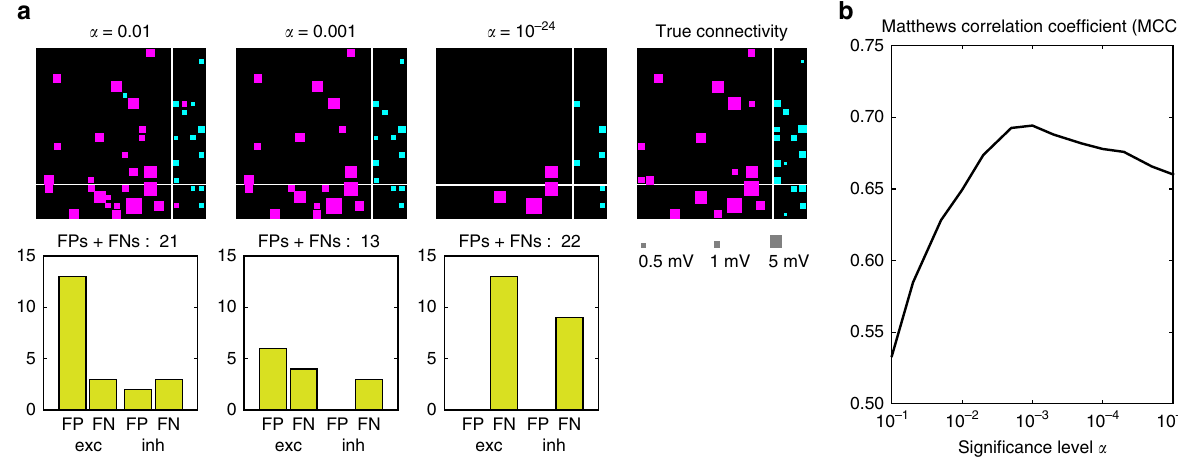
Fig. 2 Selecting the signi fi cance level. a The connection matrices are estimated with different levels of conservatism against making false positives (FPs), which are represented by the signi fi cance level α . In each connection matrix, the x -axis indicates reference (index) neurons. The connection matrix is divided into four quadrants representing inhibitory – excitatory, excitatory – excitatory, excitatory – inhibitory, and inhibitory – inhibitory zones. The numbers of FP and false negative (FN) connections for the excitatory and inhibitory categories are depicted below the matrices. In the true connectivity, weak excitatory connections whose EPSPs are smaller than 1 mV are not considered. b The Matthews correlation coef fi cient (MCC) is plotted against the signi fi cance level α . The MCC takes a maximum at an intermediate level of cautiousness, given by α ¼ 0 : 001. Source data are provided as a Source Data fi le Table 1 Duration of spike recording required for verifying neuronal connections Firing